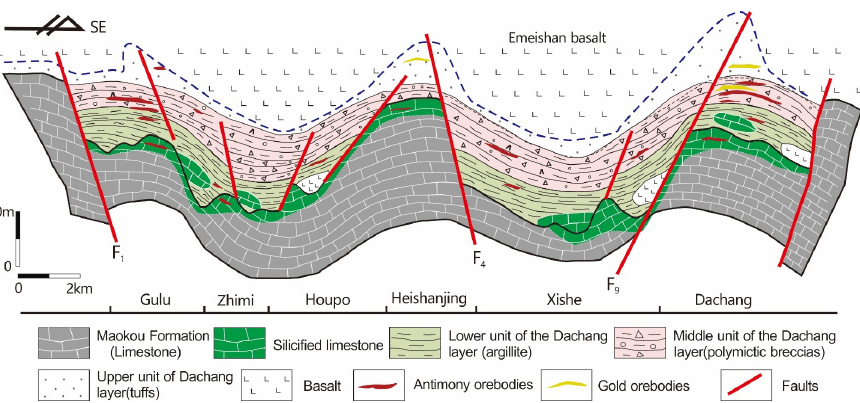
Figure 4. Lithologic variation and orebody occurrence in “Dachang layer” (modified after [27]).